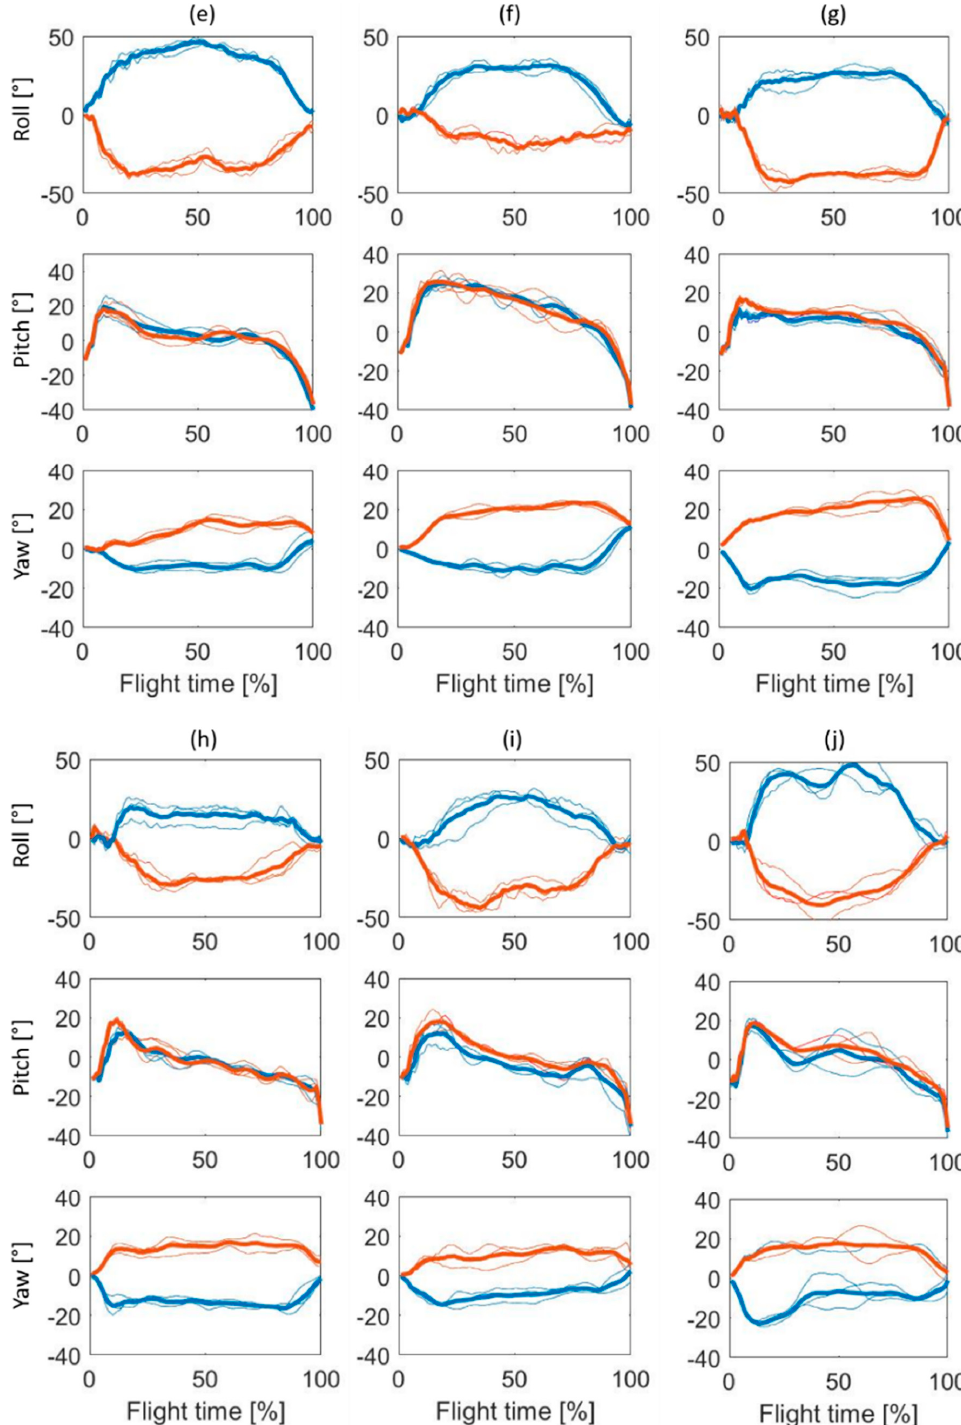
represents the right ski. The thick lines represent the average of the three normalized trajectories of each athlete, while the thin lines show the trajectory of a single jump.